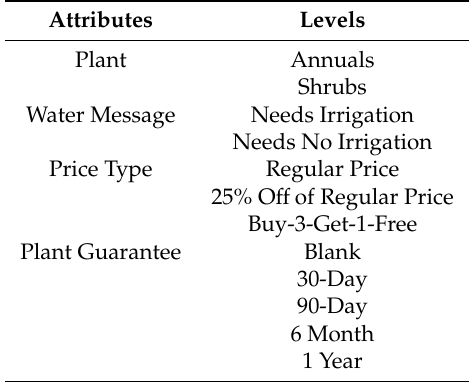
Table 1. Attributes and levels within the conjoint